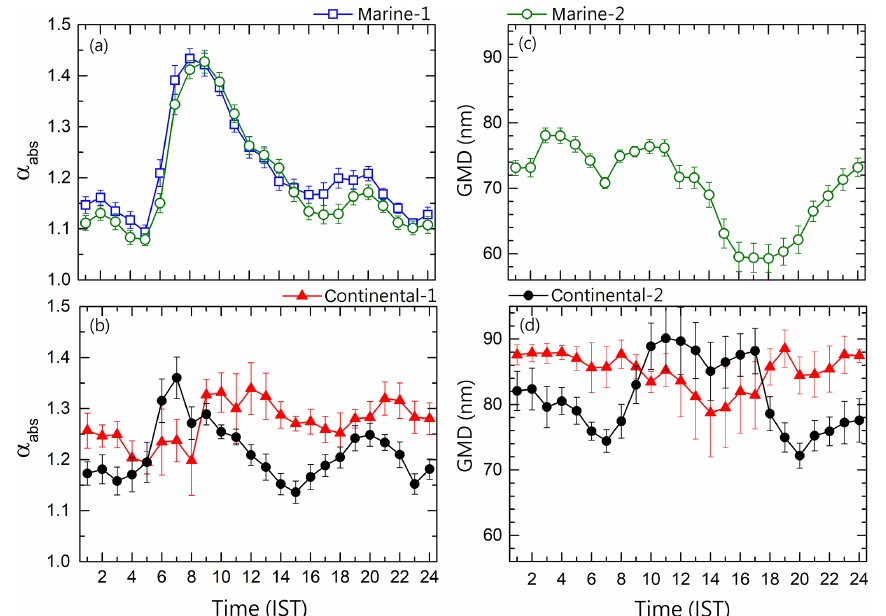
Figure 10. Diurnal variation of absorption Ångström exponent ( a and b ) and geometrical mean diameter ( c and d ) during continental and marine conditions. Error bars indicate the standard error associated with the mean